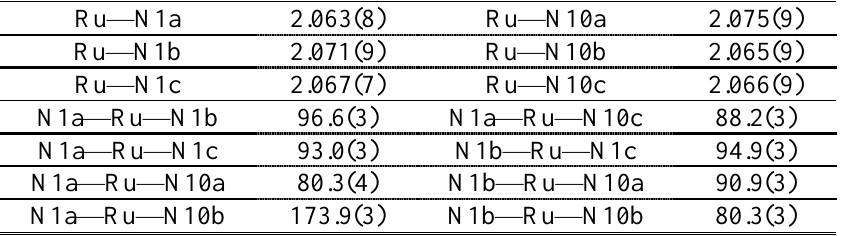
Table S4 : Selected geometric parameters (Å, °) in 3 ·6MeOH.